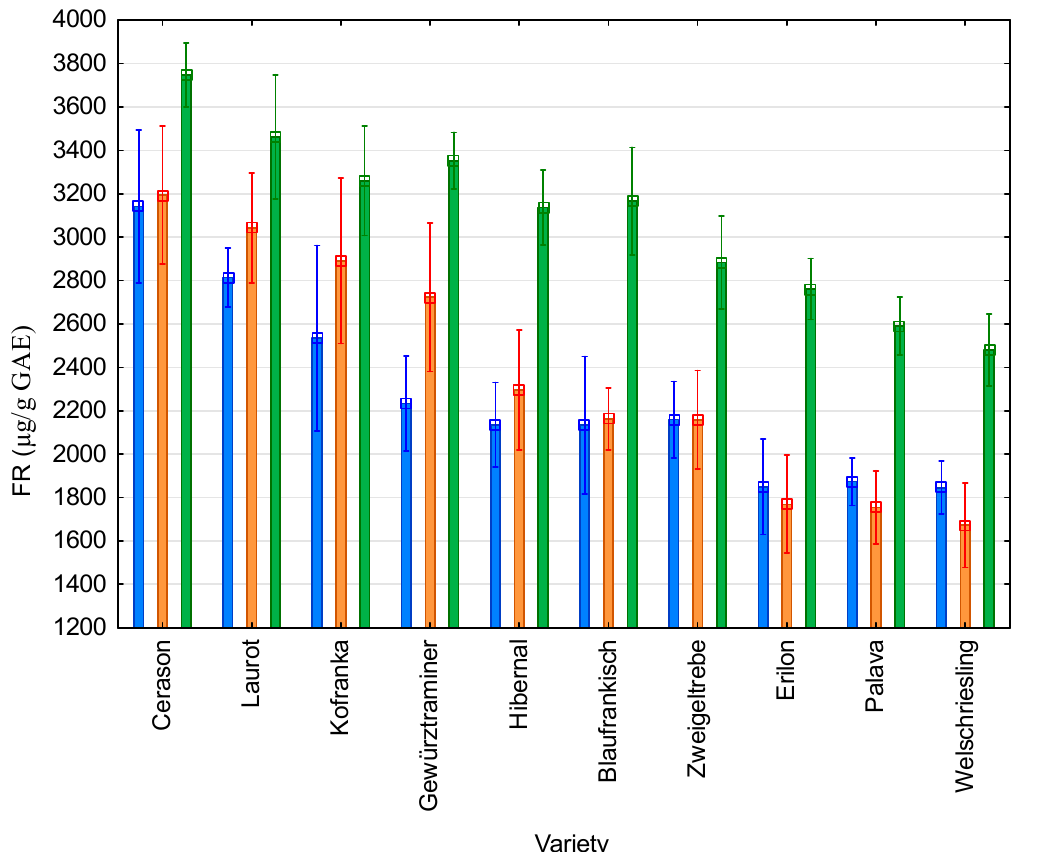
Figure 4. Values of antioxidant activity obtained using the chlorophyllin free radical method for individual vine varieties in 2015 (blue bars), 2016 (orange bars), and 2017 (green bars).2015: p < 0.01, 2016: p < 0.01, 2017: p < 0.01.